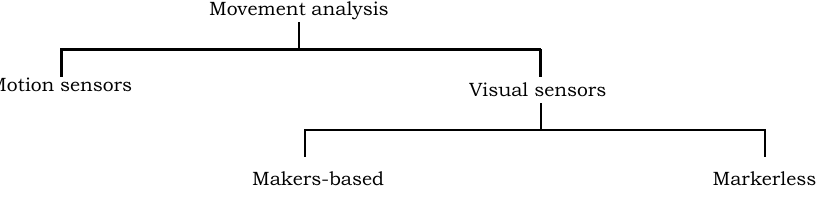
Figure 1. The distribution of existing techniques for movement analysis of human body parts into various